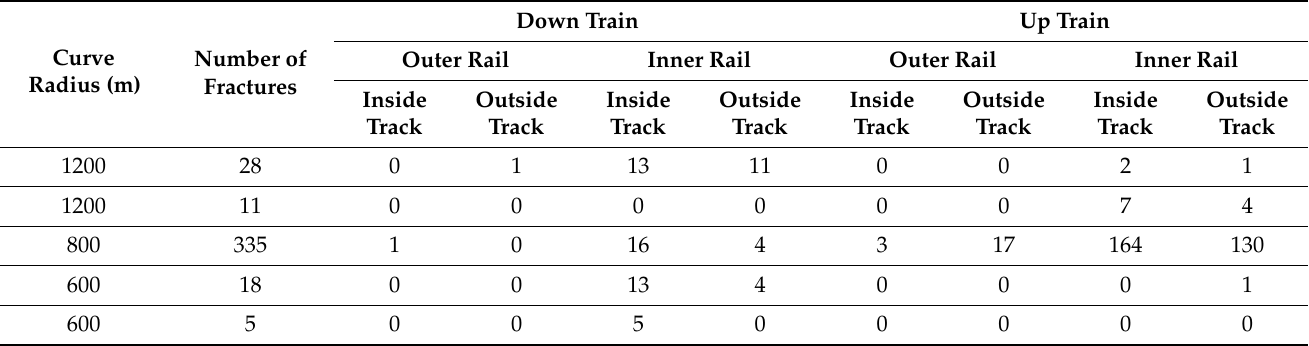
Table 1. The damage status of the tension clamps on an urban